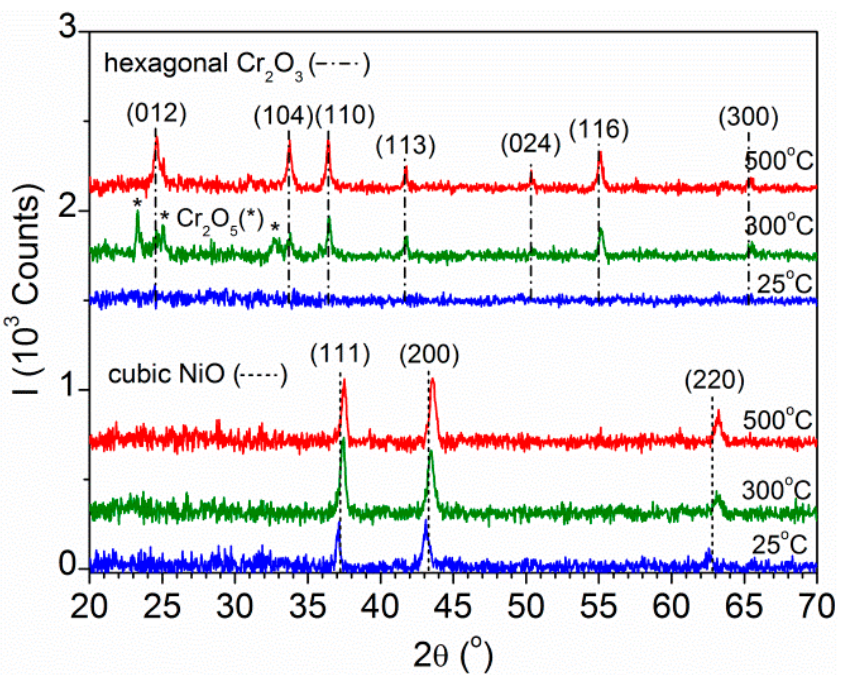
Figure 1. XRD patterns corresponding with the nickel oxide and chromium oxide samples as grown at room temperature and after heating in air at 300 °C or 500 °C. The symbol * marks the peaks attributed to Cr 2 O 5 .